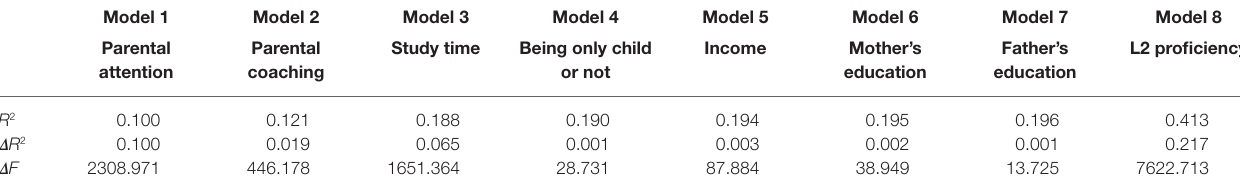
TABLE 4 | Hierarchical regression predicting L2 engagement: model summary. Model